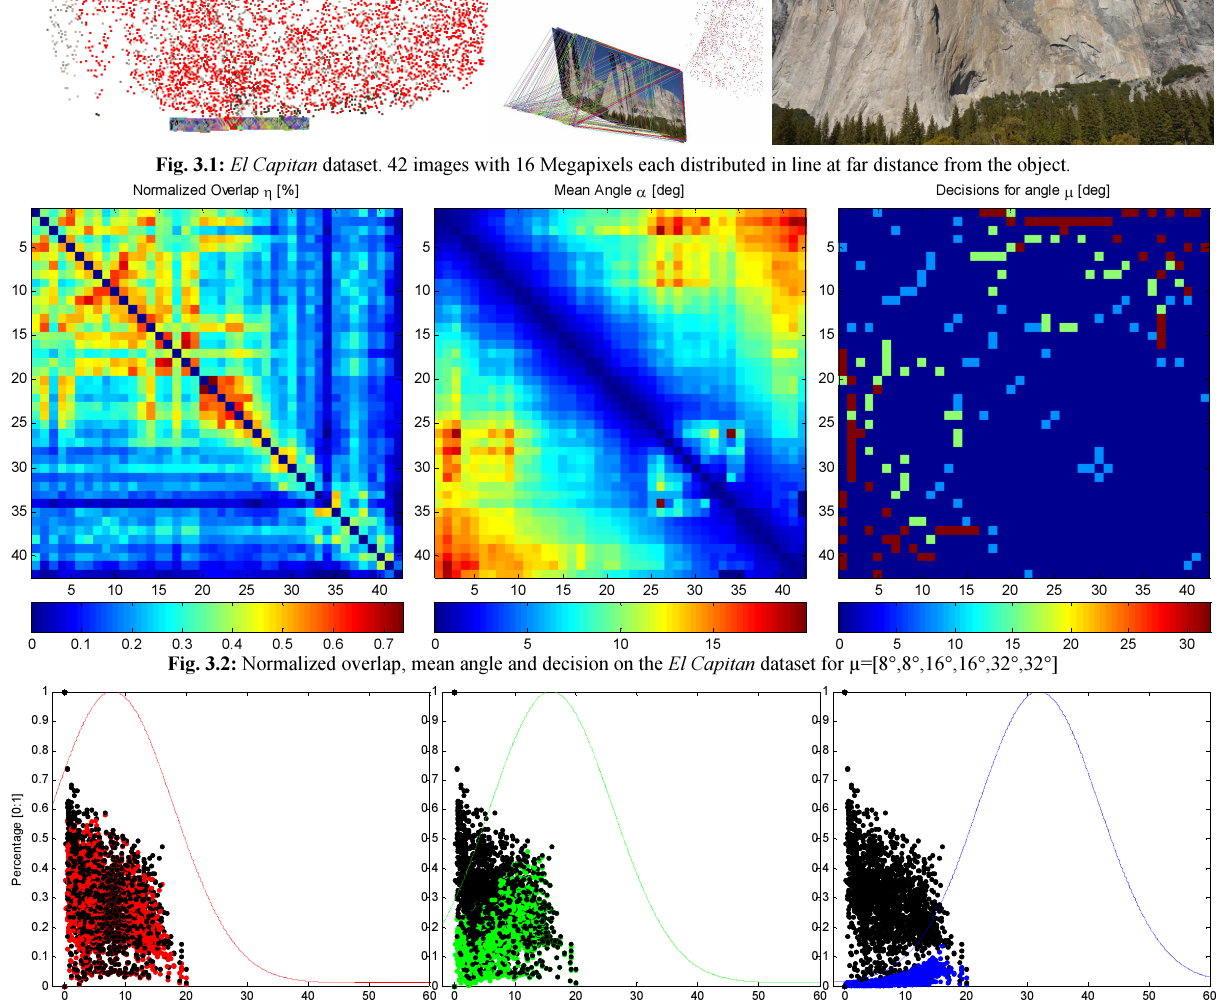
Fig. 3.3: Decision criterion for angles 8° (red), 16° (green) and 32° (blue). Dotted, black: overlap information. Line: theoretical distribution based on angle only. Dotted: effective distribution of criterion based on the angle including the overlap factor for El Capitan example dataset.